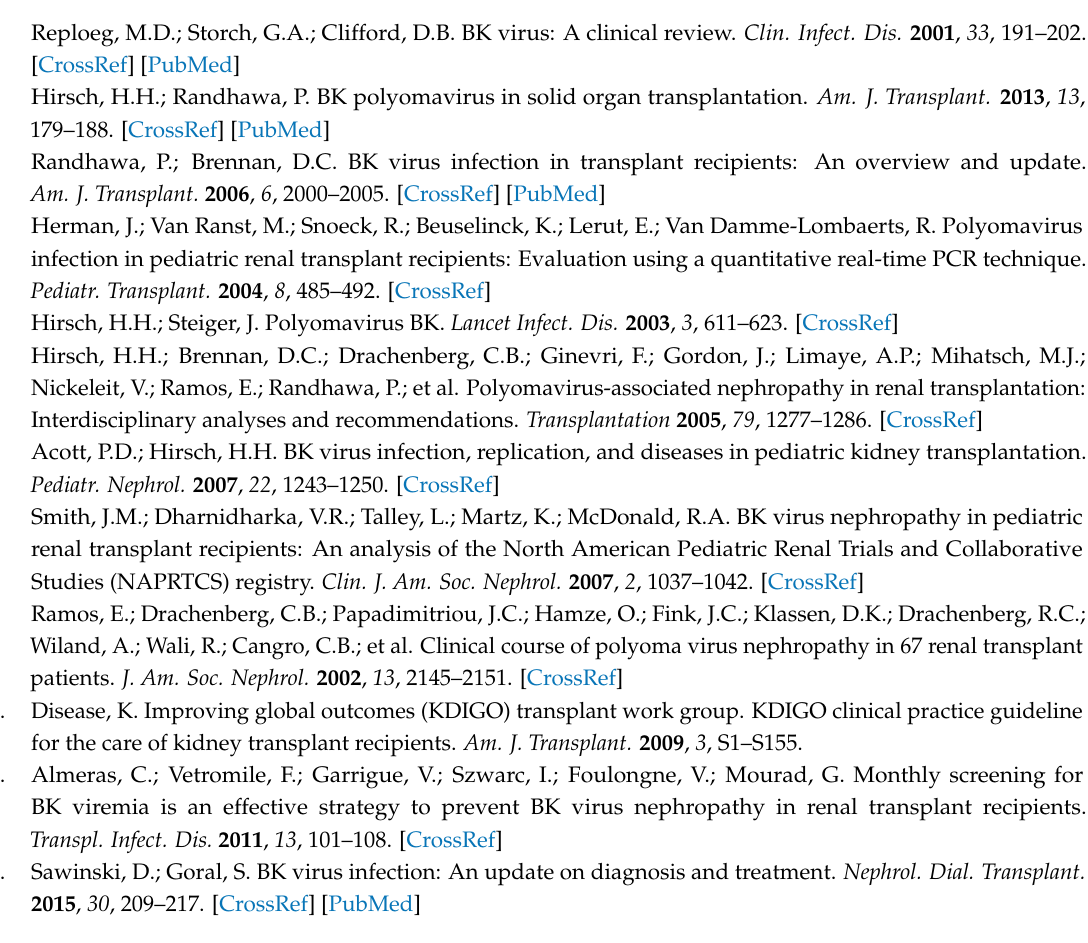
Table S1: Baseline characteristics of patients with and without BK viremia, Table S2: Risk factors for BK viremia, Table S3: Comparison between the BKVN group and only-BK viremia groups. Author Contributions: Conceptualization, Y.H.C., H.S.H., E.P., K.C.M., S.-I.M., J.H., I.-S.H., H.I.C., Y.H.A.,